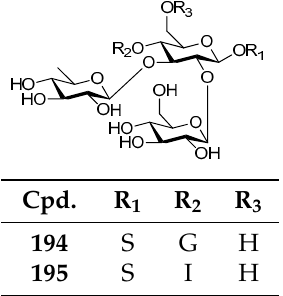
Figure 27. Structure of compound 193 .